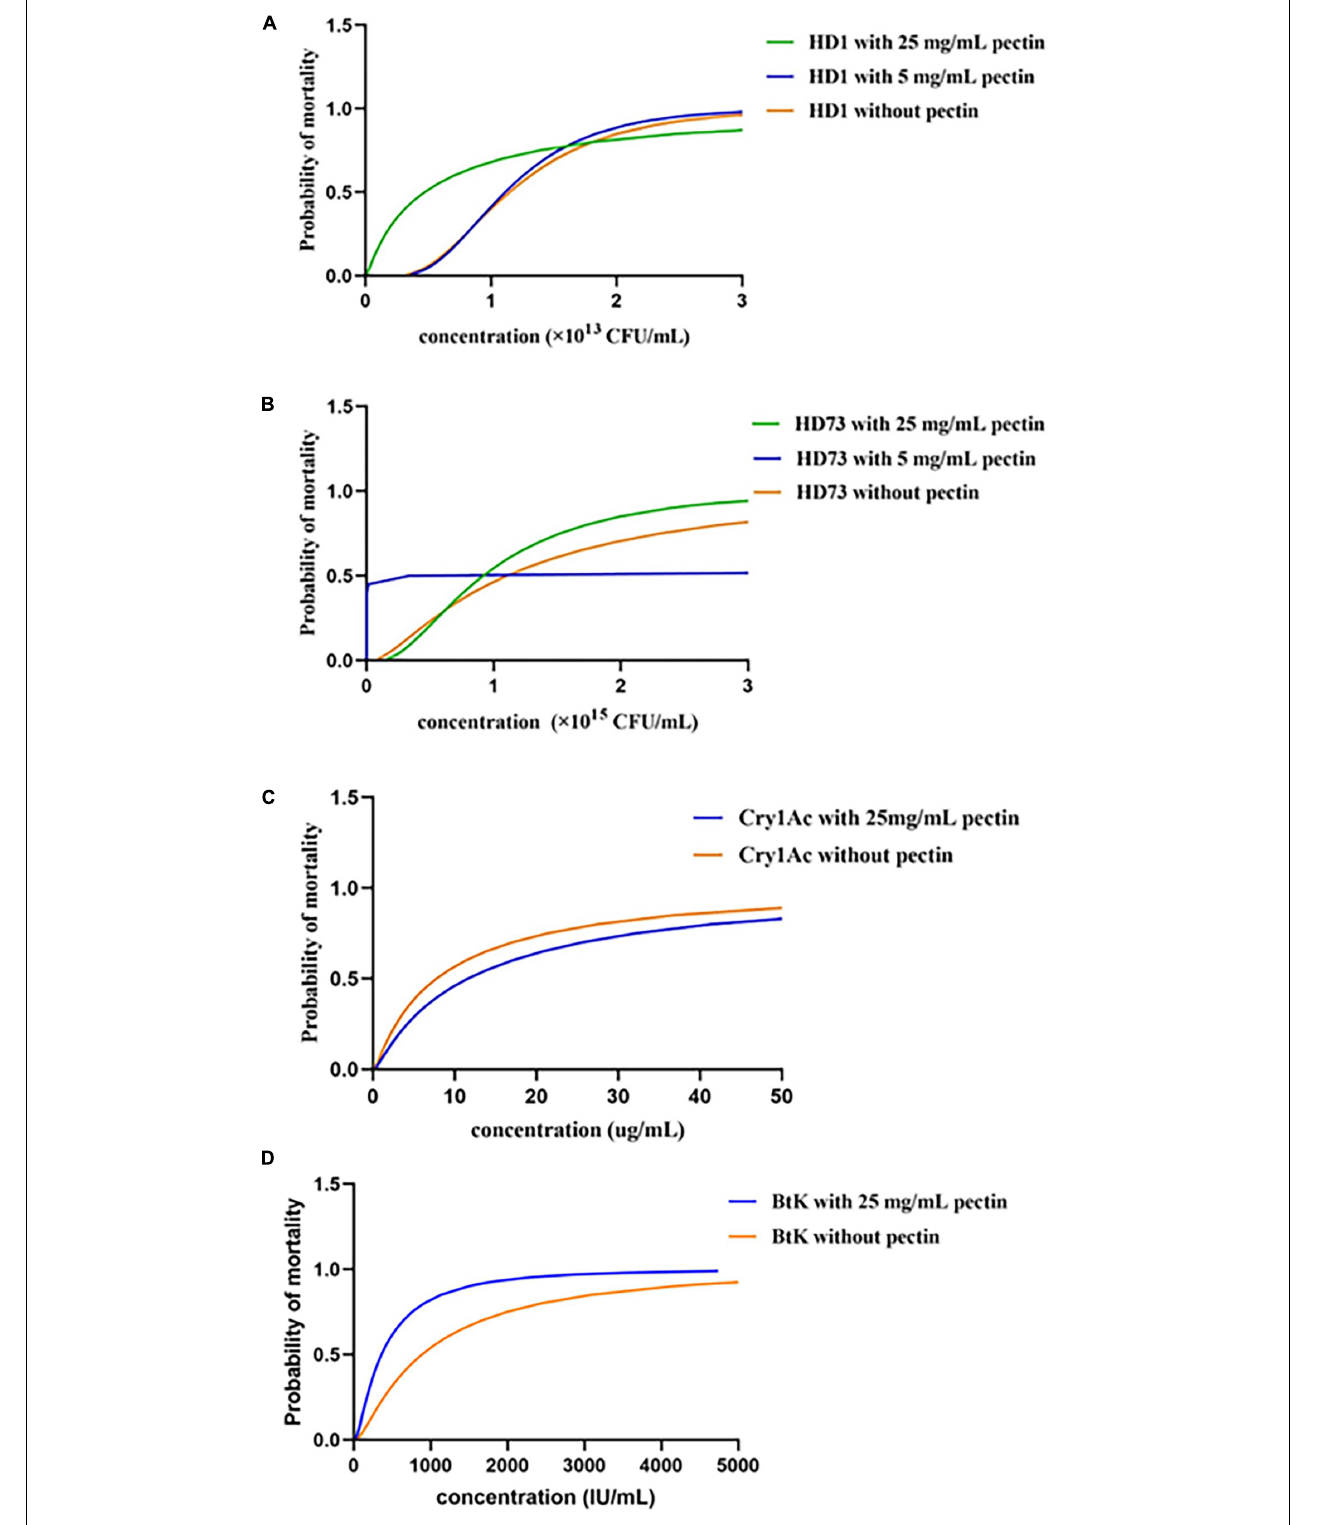
FIGURE 7 | Effects of pectin on the biocontrol activities of Bt strains and preparations. (A,B) Effect of pectin on the biocontrol activities of the spore–ICP mixtures of Bt strains HD1 and HD73 against P. xylostella , respectively. (C) Effect of pectin on the biocontrol activity of Cry1Ac extracted from Bt HD73 against P. xylostella ; the value of LC 50 of Cry1Ac from HD73. (D) Effect of pectin on the biocontrol activity of BtK preparations against P. xylostella.